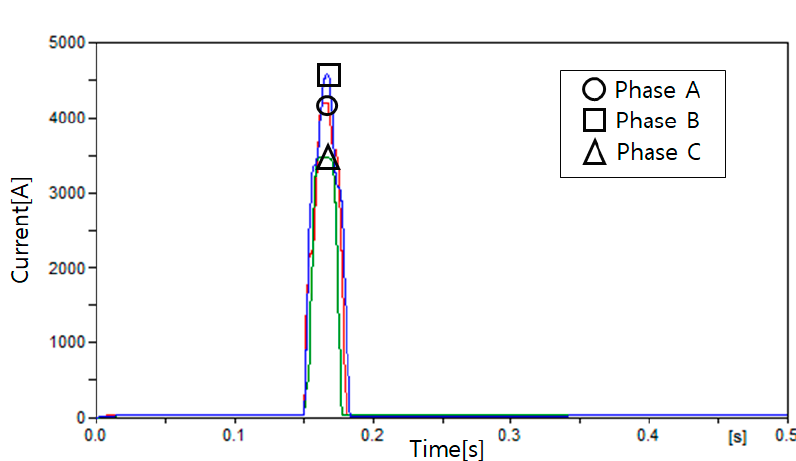
Figure 20. Current measured at I 2 in Case 5.